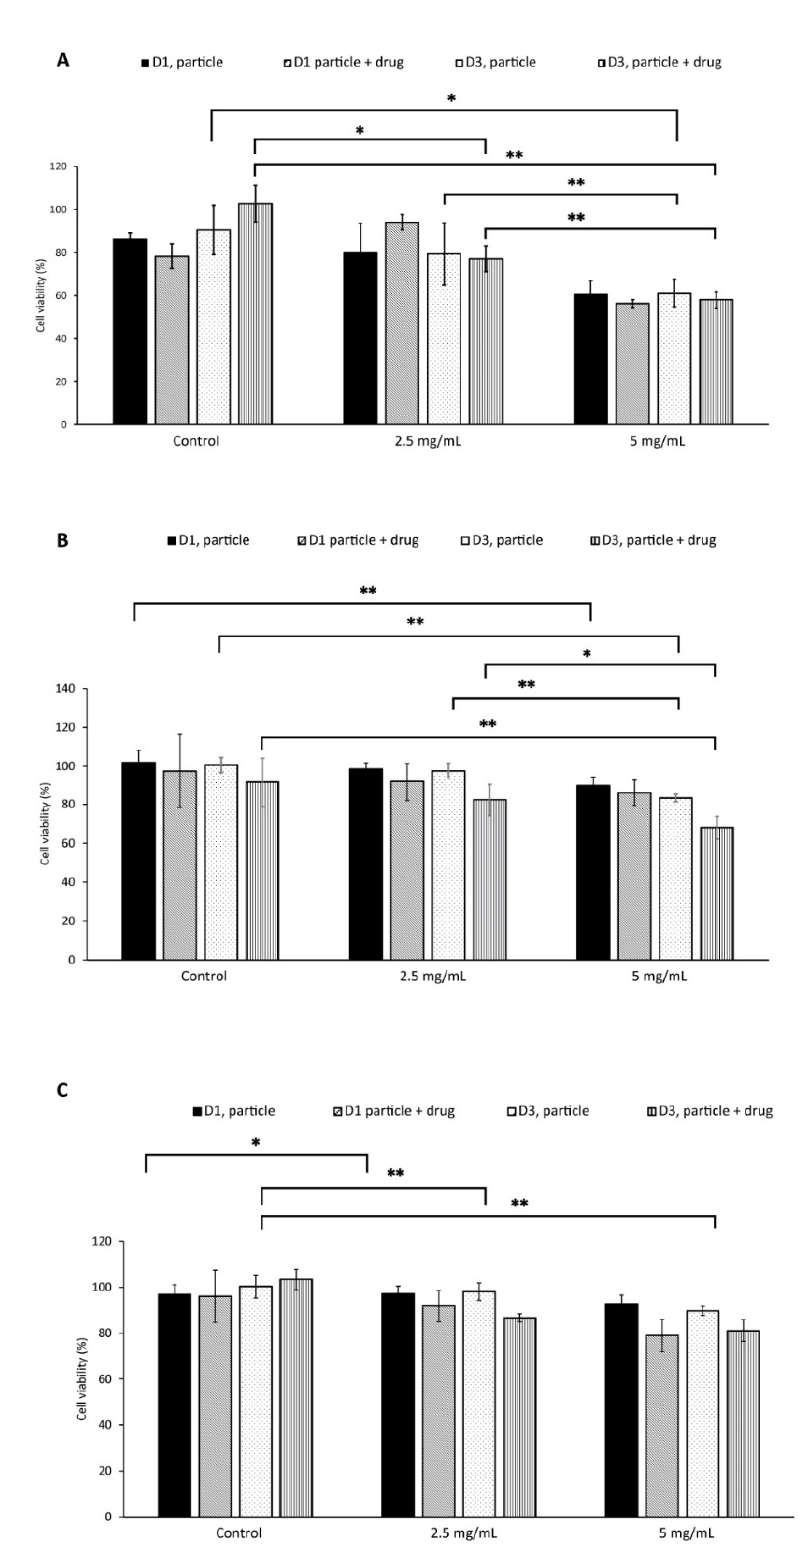
Figure 9. Cell viability after particle solution treatment for 10,000 cell/well ( A ), 20,000 cells/well ( B ), and 40,000 cells/well ( C ). The cells were treated with 2.5 mg/mL and 5 mg/mL. For each concentration particle with (+) and without ( − ) Hydroxyurea was tested. All p values listed used the parametric ANOVA and Tukey posthoc analysis, n = 6, * indicates p < 0.05, and ** indicates p < 0.01.